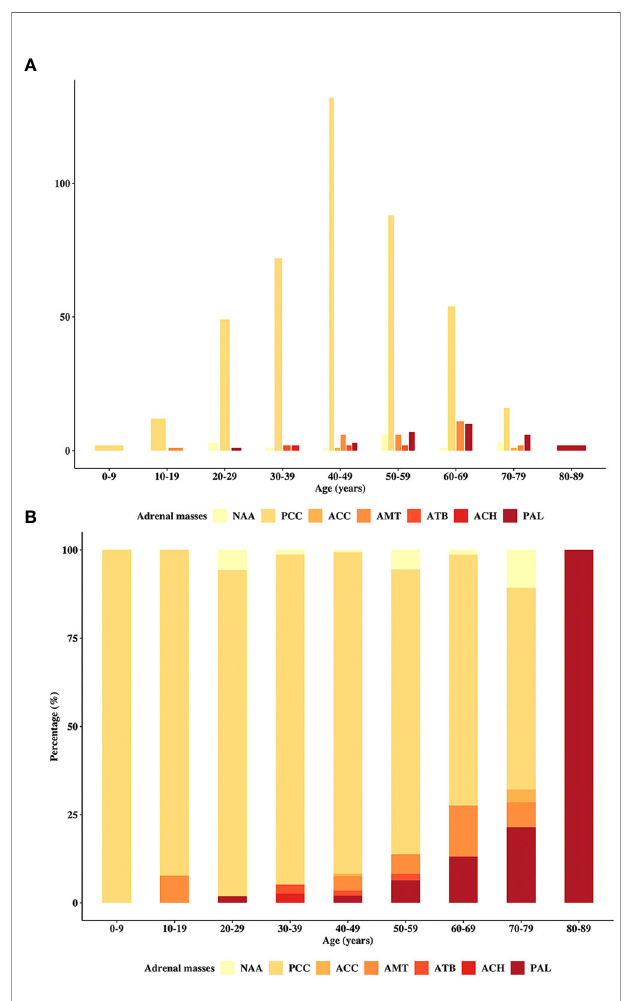
FIGURE 1 | Distribution of the patients in the primary study by age. The incidence of the cohort patients strati fi ed by the age at diagnosis, including (A) absolute and (B) proportional cases. PAL, primary adrenal lymphoma; NAA, nonfunctional adrenal adenoma; PCC, pheochromocytoma; ACC, adrenocortical carcinoma; AMT, adrenal metastasis; ATB, adrenal tuberculosis; ACH, adrenocortical